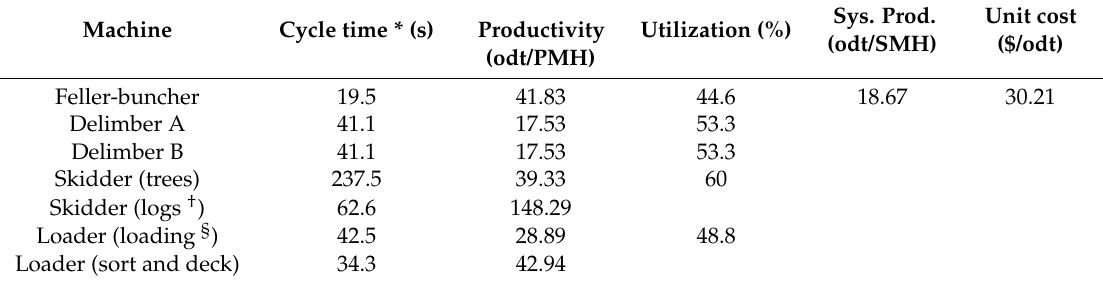
Table 6. Performance metrics of individual machines and the entire system of whole-tree harvesting predicted by the TS model.